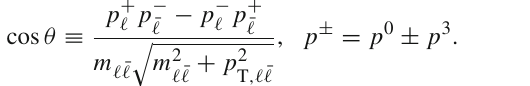
of the associated forward–backward asymmetry by review- ing the LO kinematics, determining LO analytic expressions, results of LO and NLO numerical simulations obtained